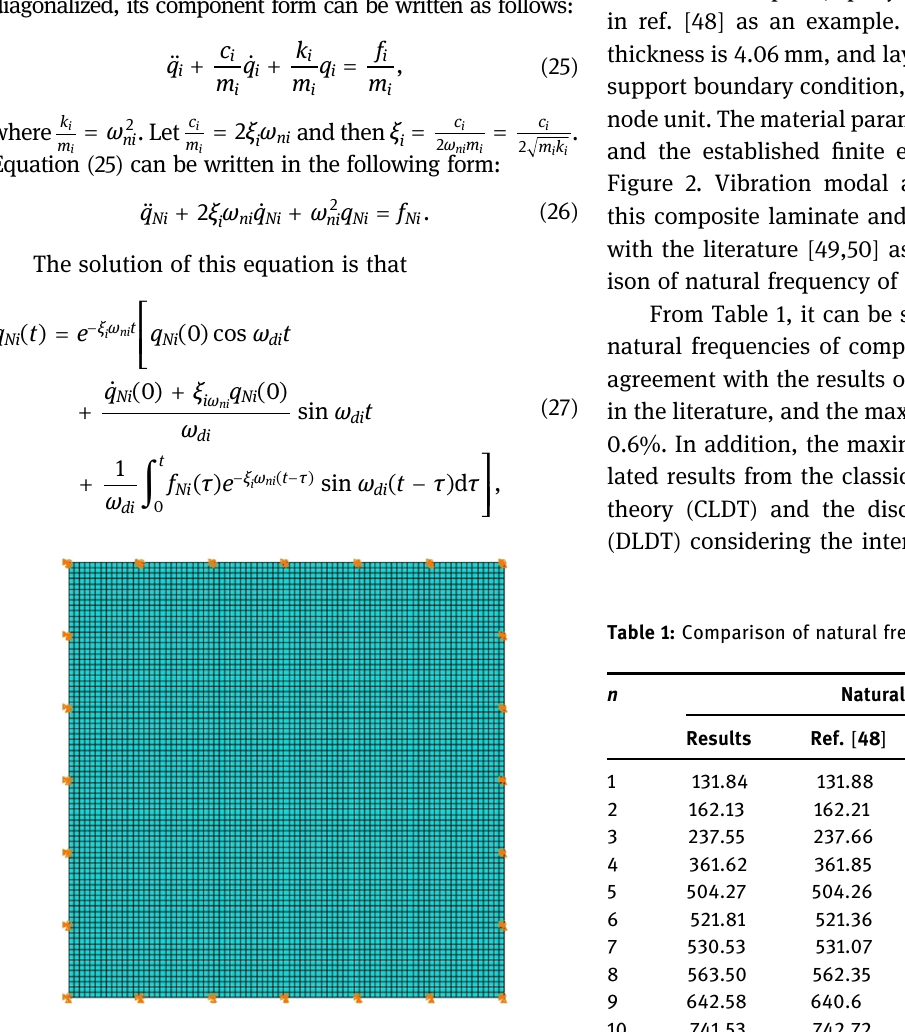
Figure 2: Finite element model of composite laminate.